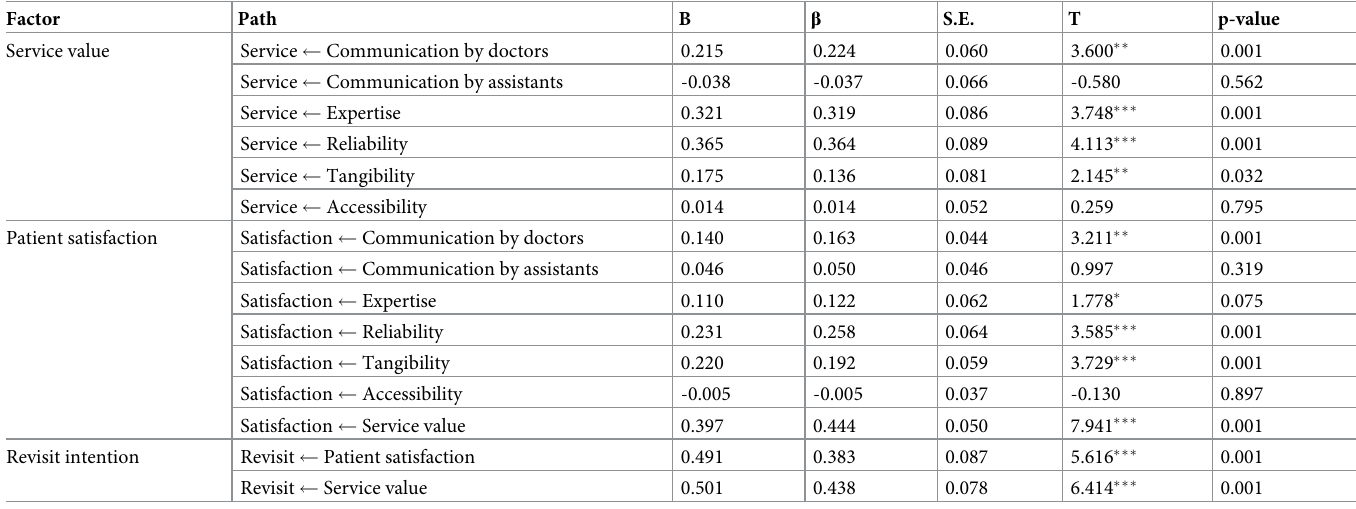
Table 6. Research model path